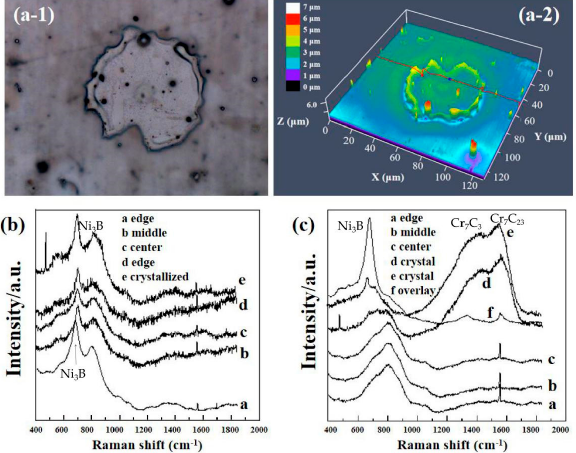
Figure 2. XRD patterns of (a) raw NiCrBSi powder, and (b) post heat-treated and (c) plasma sprayed NiCrBSi coating.